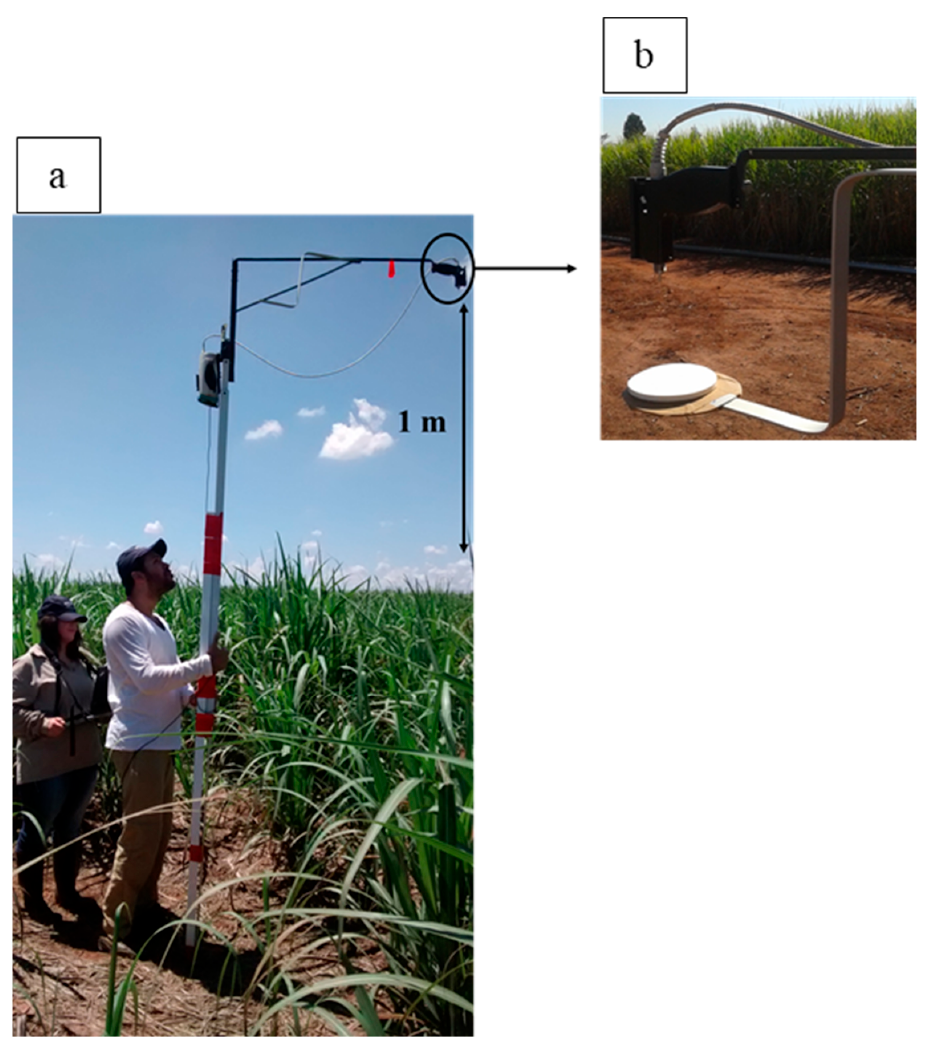
Figure 4. Representation of the hyperspectral sensor in the field ( a ) and Lambertini plate used for calibration ( b ).